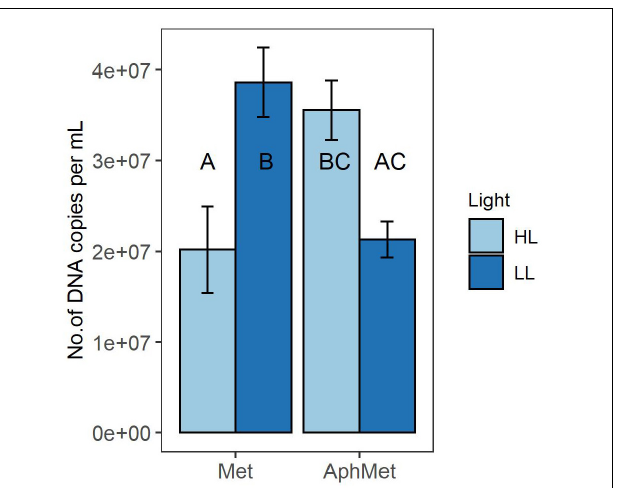
FIGURE 4 | Yield of Methylosinus in the absence (Met) and presence (AphMet) of Aphanizomenon gracile under high light (HL) and low light (LL) conditions. The growth of Methylosinus is expressed as the number of pmoA gene copies per mL of medium. The same letters indicate homogenous groups. Bars represent the mean ± standard error ( n = 5 for each